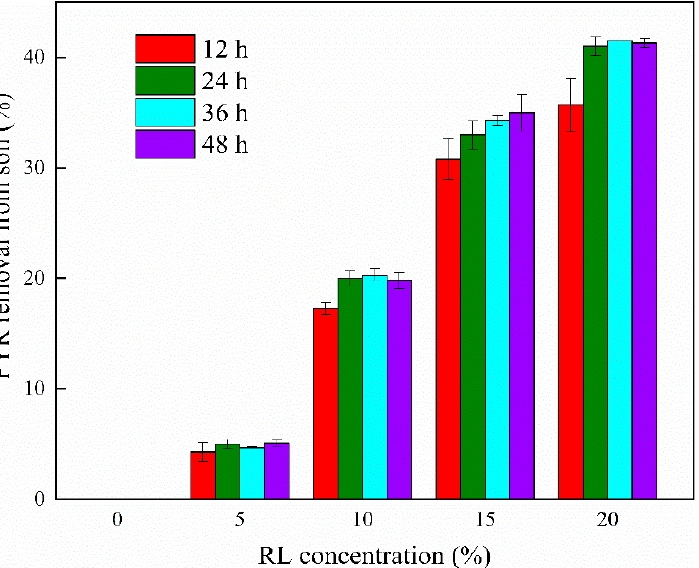
Figure 1. Effect of rhamnolipid concentration on elution rates. Experimental conditions: 25 °C, 160 rpm; no pH adjustment.